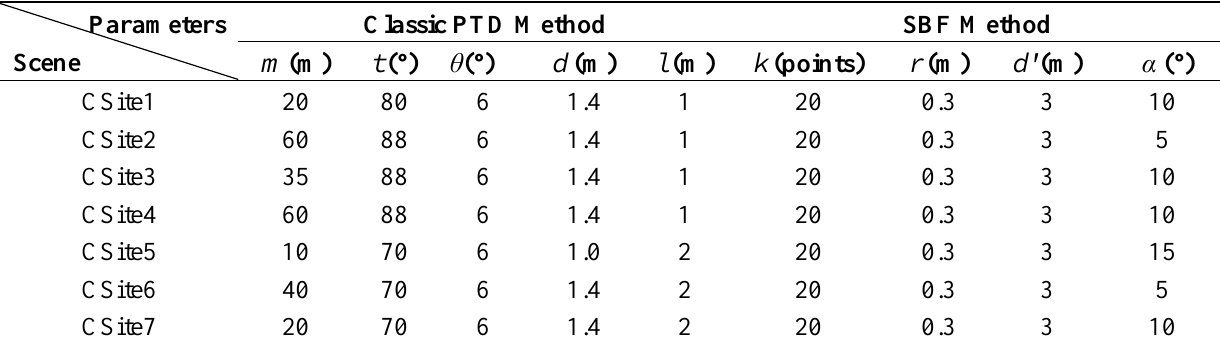
Table 1. Input Parameters of the two filters used for each site.